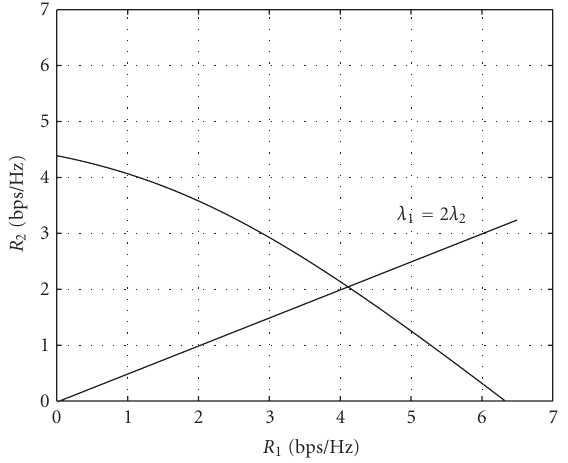
Figure 2: C BC for the 2-user scenario.